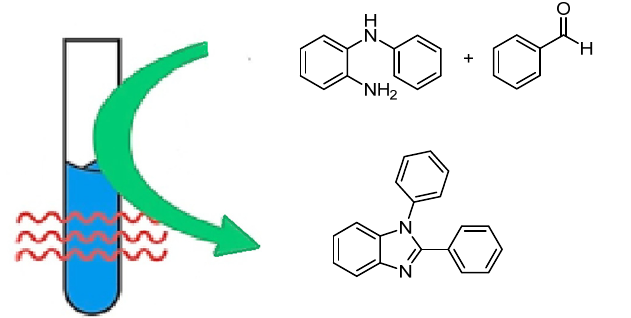
Figure 2. The environmental synthesis of 1,2-disubstituted benzimidazoles by microwave irradiation and Er(OTf) 3 .